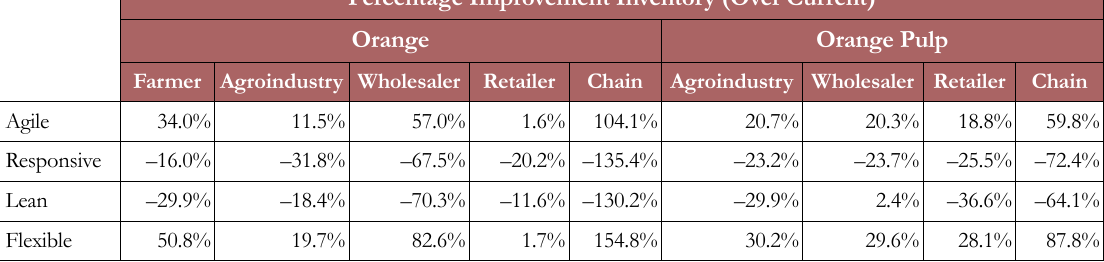
Table 7a. Percentage Change inventory for Mango